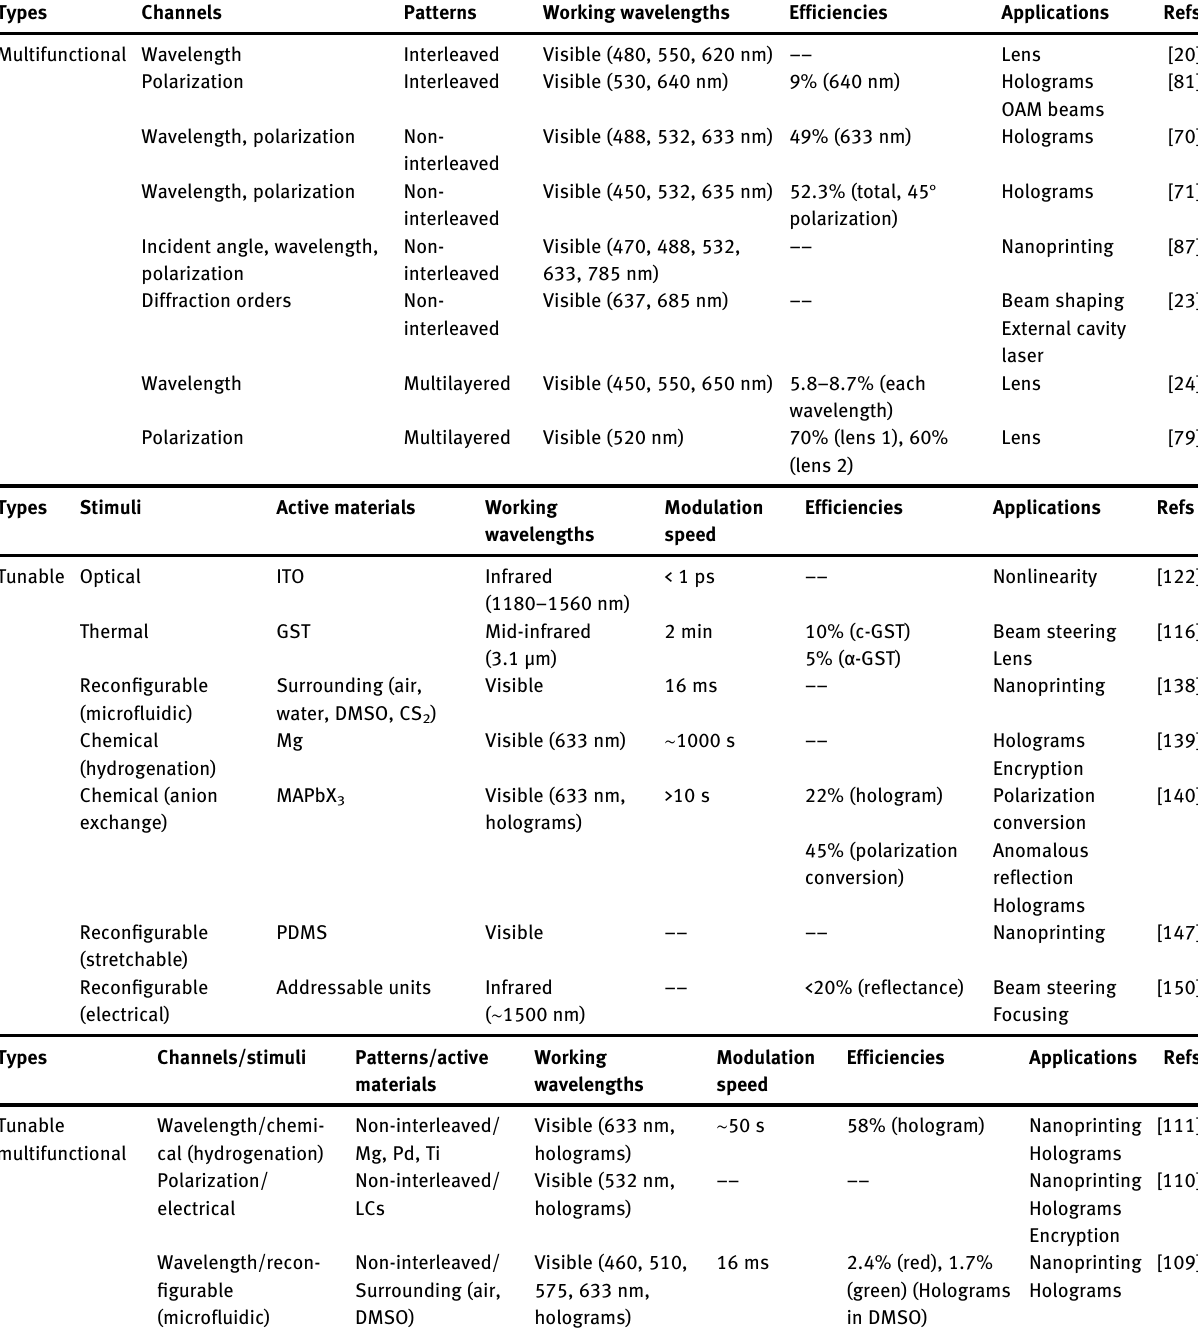
Table  : Comparison of typical studies to achieve multifunctional and tunable